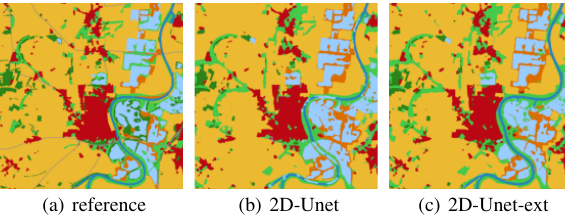
Figure 4. Exemplary prediction results for one tile in R 1 using 2D-Unet and 2D-Unet-ext . Colour code: cf. figure